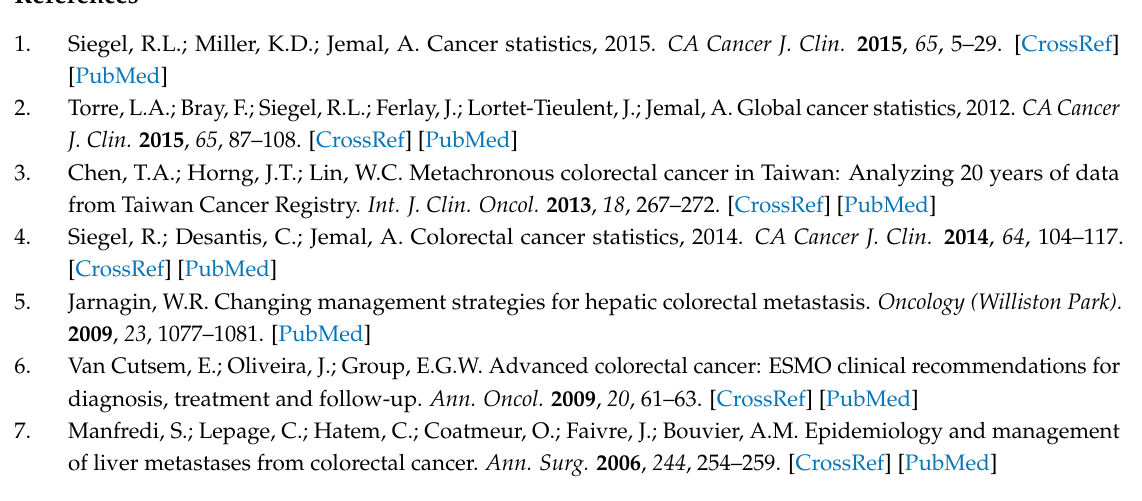
Figure S1: The circos plot of seven clinical variables. Red: gain; Blue: loss. Circular tracks from outside to inside: primary site: rectum vs others; TMN stage: 3, 4 vs 2; LN: >0 vs 0; CEA elevation: y vs n; multifocal vs N; synchronous meta: y vs n; recurrence: y vs n. Figure S2: The colorectal cancer metastasis signaling pathway. Blue: Relapse and synchronous metastasis-associated probes, Table S1: Two hotspot regions of recurrence-associated candidate genes in 21 CRCLM